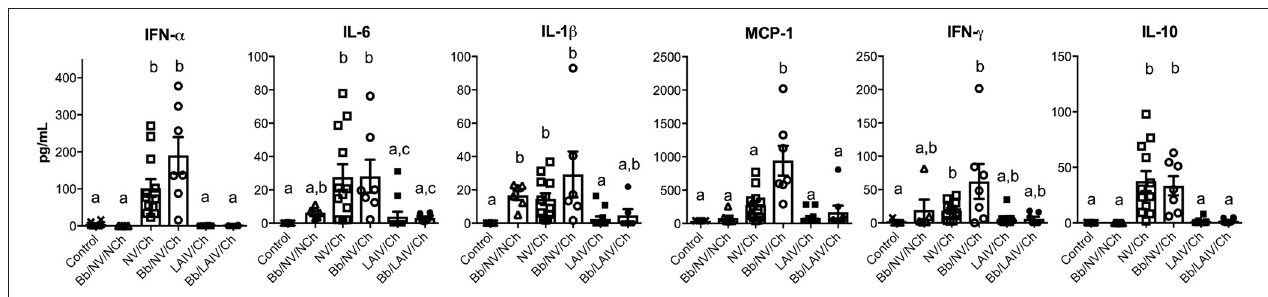
FIGURE 7 | Altered cytokine levels in the lung were associated with IAV challenge on non-vaccinated pigs, regardless of B. bronchiseptica colonization. Groups of pigs were inoculated with B. bronchiseptica (Bb) on day − 7, LAIV on days 0 and 21, and subsequently challenged (Ch) with heterologous IAV as described in materials and methods. On 5 days post-infection lung lavage was collected and levels of indicated cytokine measured by multiplex ELISA. Each dot represents a single animal in that respective treatment group with mean ± SEM shown and was analyzed using a Kruskal-Wallis test with a Dunn’s multiple comparisons post-test (GraphPad Prism 6). Groups with different letter designations were significantly different ( p <